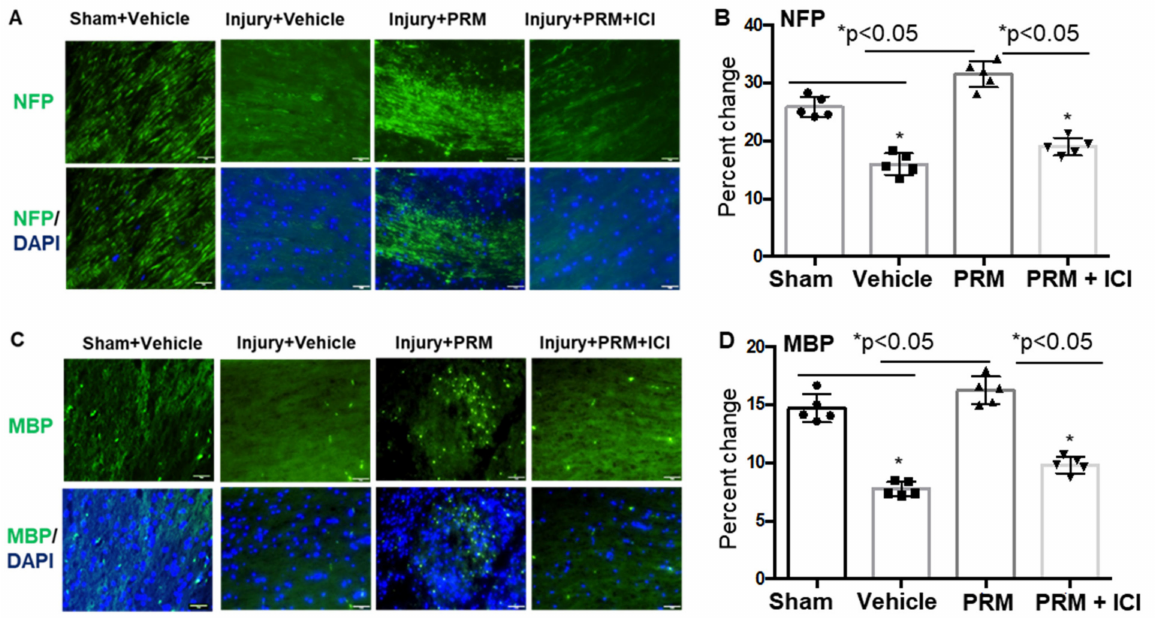
Figure 3. PRM treatment increased neurogenesis and decreased myelin damage at day 7 following SCI. Increased levels of immunostaining of NFP ( A , B ) and MBP ( C , D ) were detected in longitudinal lesioned sections of injured rats following treatment with PRM. These NFP and MBP levels were significantly improved in PRM treated rats when compared with vehicle treatment. In contrast, there was a significant reduction of NFP protein expression in PRM + ICI treated rats as compared to PRM, indicating the effects of PRM treatment. Similarly, MBP expression levels were also markedly reduced in PRM + ICI treated rats as compared to PRM. These data suggest that neuronal growth as well as myelination are improved following treatment of SCI rats with PRM. Representative immunofluorescent staining images were shown (Magnification, 20 × , n = 5–6). Statistical analysis was performed by one-way ANOVA followed by Fisher’s post-hoc test. Error bars are standard deviations. (* p <